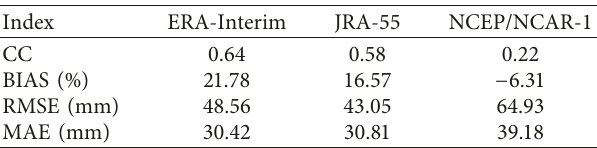
Figure 3: The line chart of correlation coefficient (CC) between monthly observed precipitation and ERA-Interim, JRA-55, and NCEP/NCAR-1 precipitation during 2000 to 2014 over the Qin- ling-Daba Mountains, Table 2: The average of CC, BIAS, RMSE, and MAE between three reanalysis precipitation datasets and gauged precipitation data on a monthly scale during 2000 to 2014 over the Qinling-Daba Mountains, China.